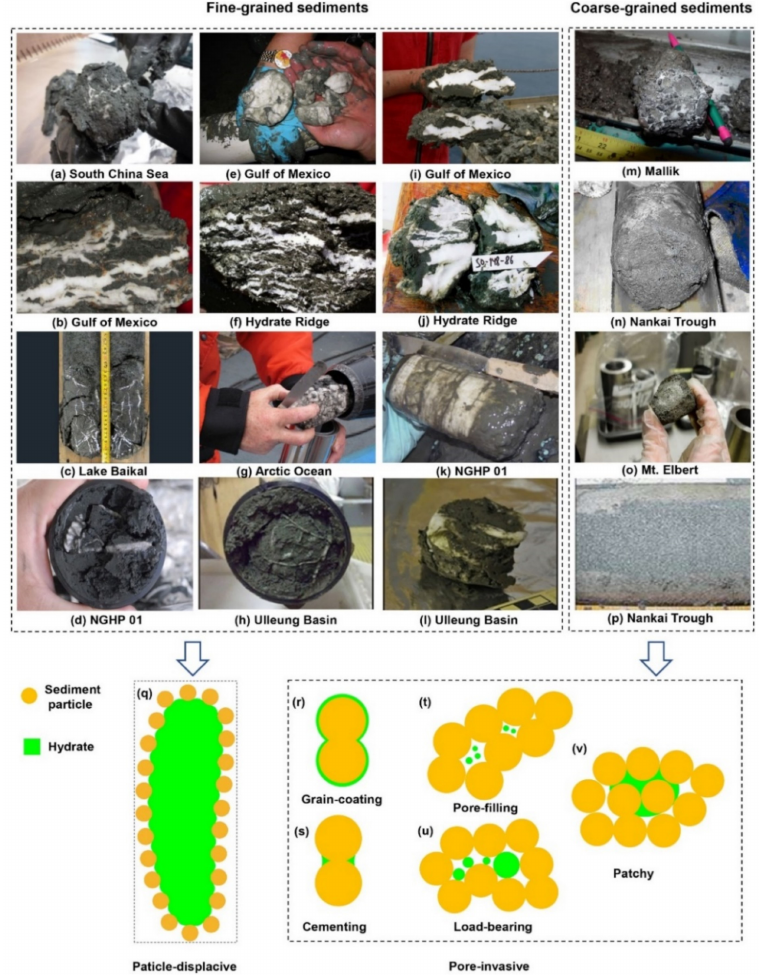
Figure 46. Core-scale hydrate morphology in hydrate samples from different geological settings and conceptual pore habits reprinted from [10] with permission from Elsevier. ( a – l ) Particle-displacive hydrate in fine-grained sediments (in white) shown as veins, lenses, and nodules; ( m – p ) coarse- grained sediments where hydrate is distributed in pores therefore not readily visible; ( q ) the formation of hydrate displaces surrounding sediment particles; ( r – u ) conceptual pore habits for hydrate in coarse-grained sediments: grain-coating, pore-filling, cementing and load-bearing; ( v ) hydrate distribution in the pore network may not be homogeneous but is likely to be locally concentrated and form